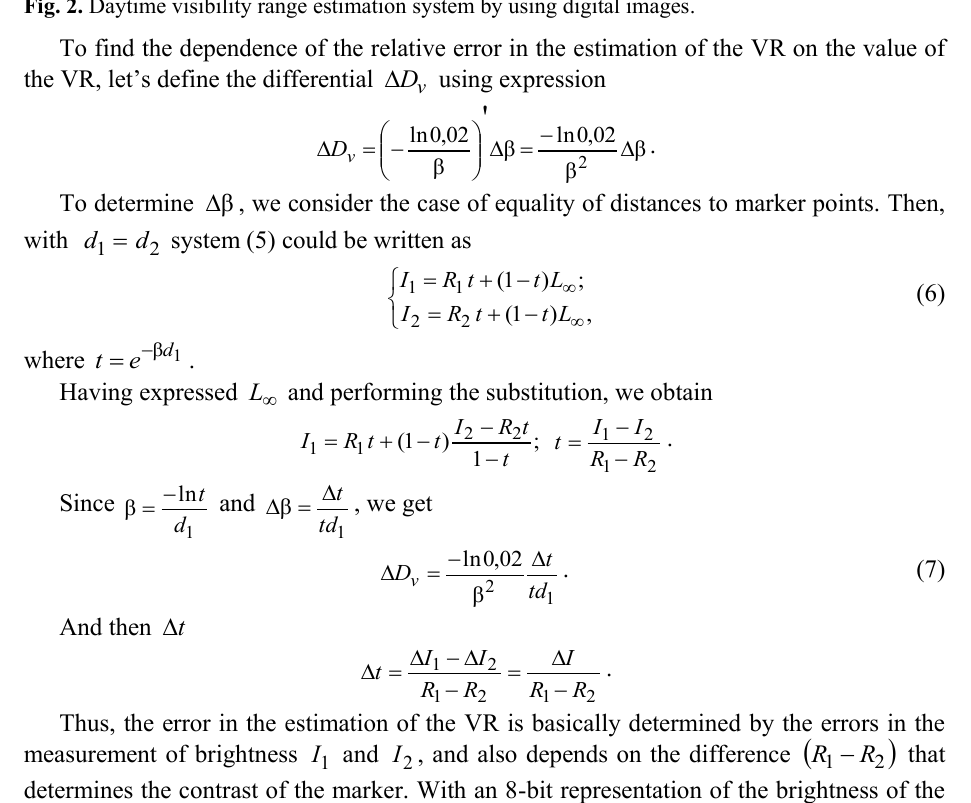
Fig. 2. Daytime visibility range estimation system by using digital